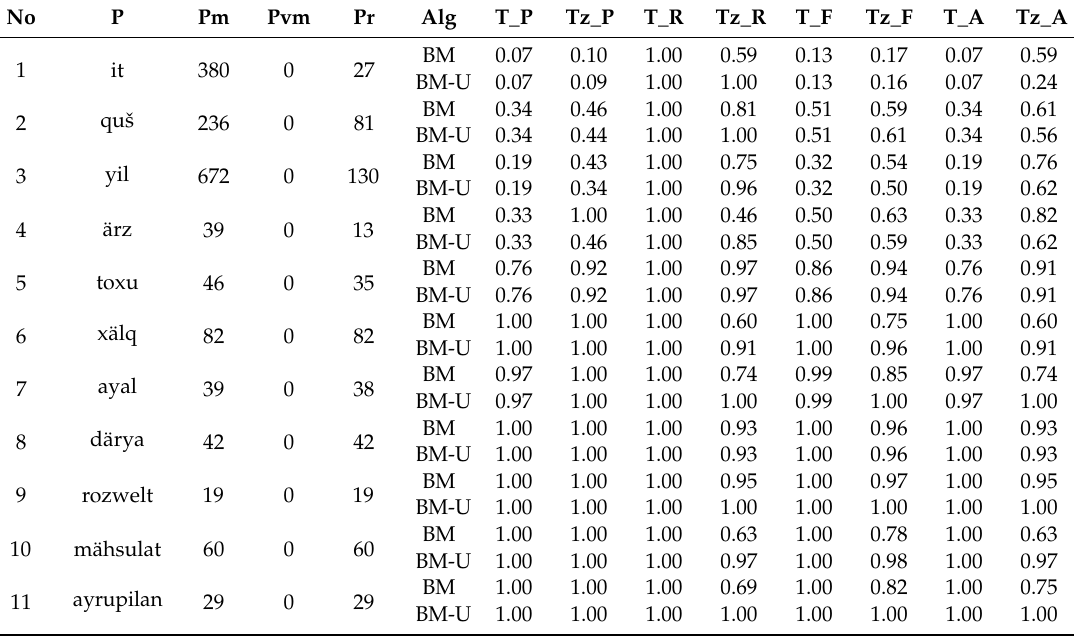
Table 5. Matching results of words without